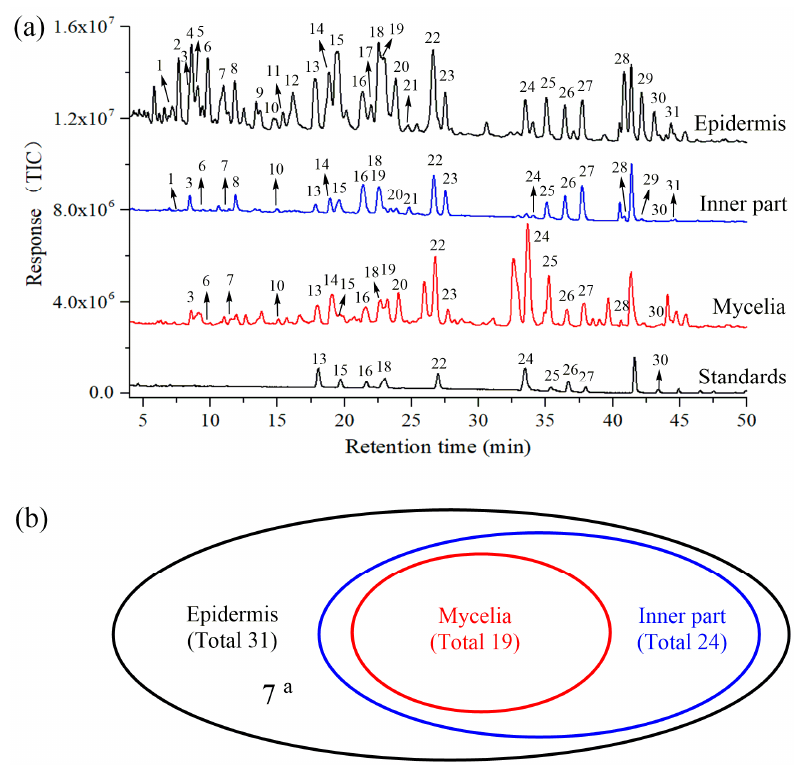
Figure 2. Total ion chromatography (TIC) of epidermis, inner part and mycelia of P. cocos and standards of triterpene acids ( a ) and Venn diagram of the number of identified triterpene acids in epidermis, inner part and mycelia of P. cocos ( b ); a , the number of triterpene acids only identified in epidermis.